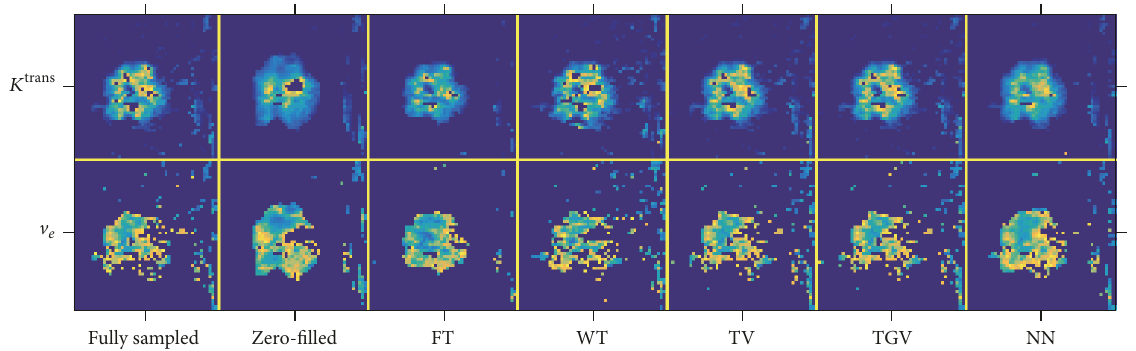
Figure 4: Zoomed 𝐾 trans and V 𝑒 maps of the first mask for all five temporal constraints. The first row shows the 𝐾 trans map for (from left to right) the fully sampled, zero-filled, WT, FT, TV, TGV 2 𝛼 , and NN. The second row is the corresponding V 𝑒 map. TV and TGV produced the most visually similar tumor maps to the fully sampled, without excessively denoising or filtering the